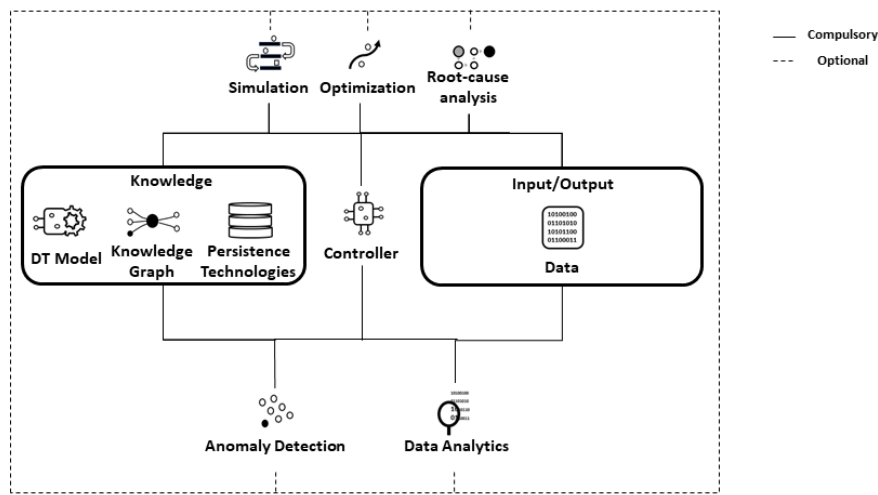
Figure 3. Cognition in the DT core.